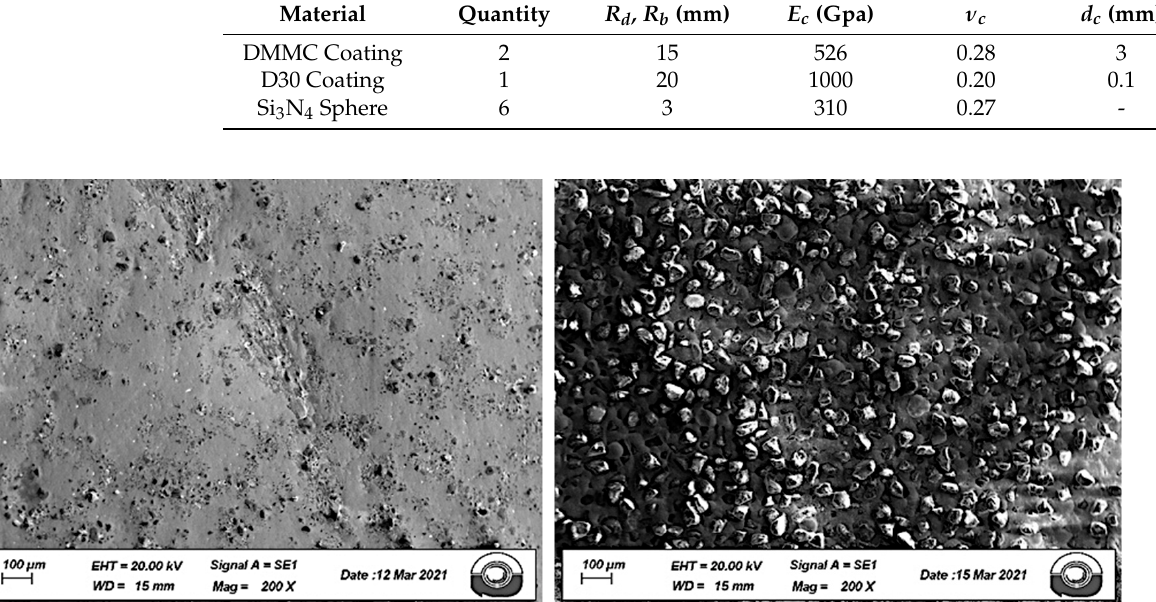
Figure 2. Microscopical front view of diamond distribution in DMMC ( left ) and D30 ( right ) coatings.